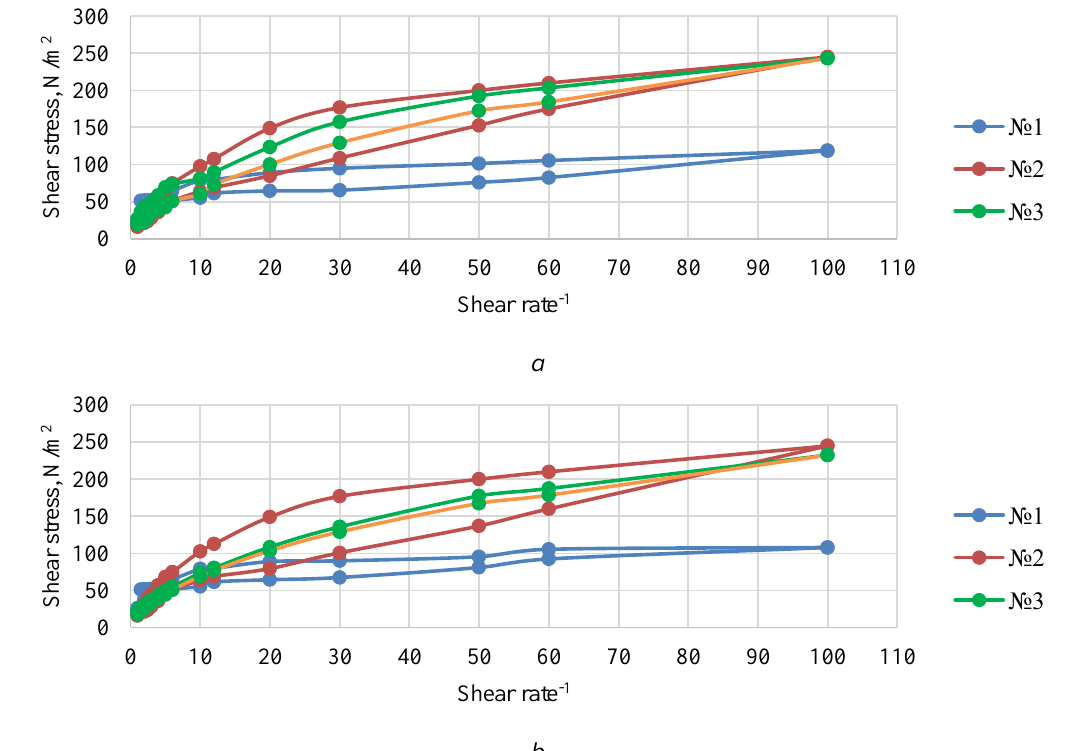
Fig. 1. Rheograms of a stream of drugs in soft dosage forms with nanoparticles of silver: a – after preparation;